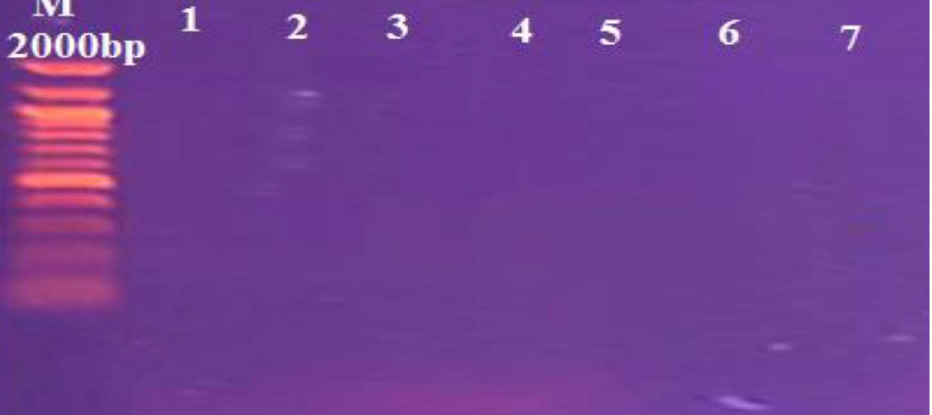
Fig. 4. Agarose gel electrophoresis image that shown the PCR product of etC gene in S. aureus isolates. Where M: Marker (100-2000bp), lane (1-7) negative PCR amplification at (549bp) PCR product size.